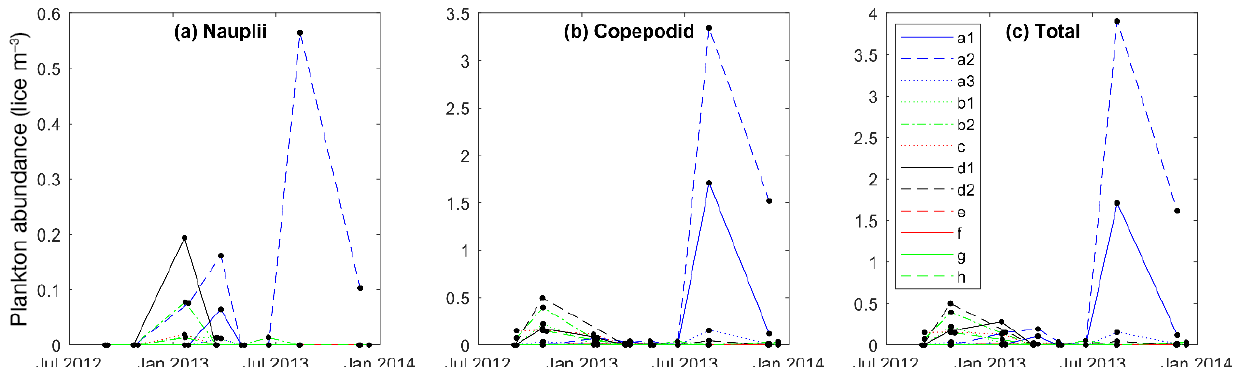
Fig. 4. Results from 92 independent plankton trawls conducted at 8 time points, showing (a) abundance of non-infective nau- plii, (b) abundance of infective copepodids, and (c) total abundance of lice. Note that y -axis scales for each panel differ, with observed copepodid stage abundances being an order of magnitude higher than those for nauplii